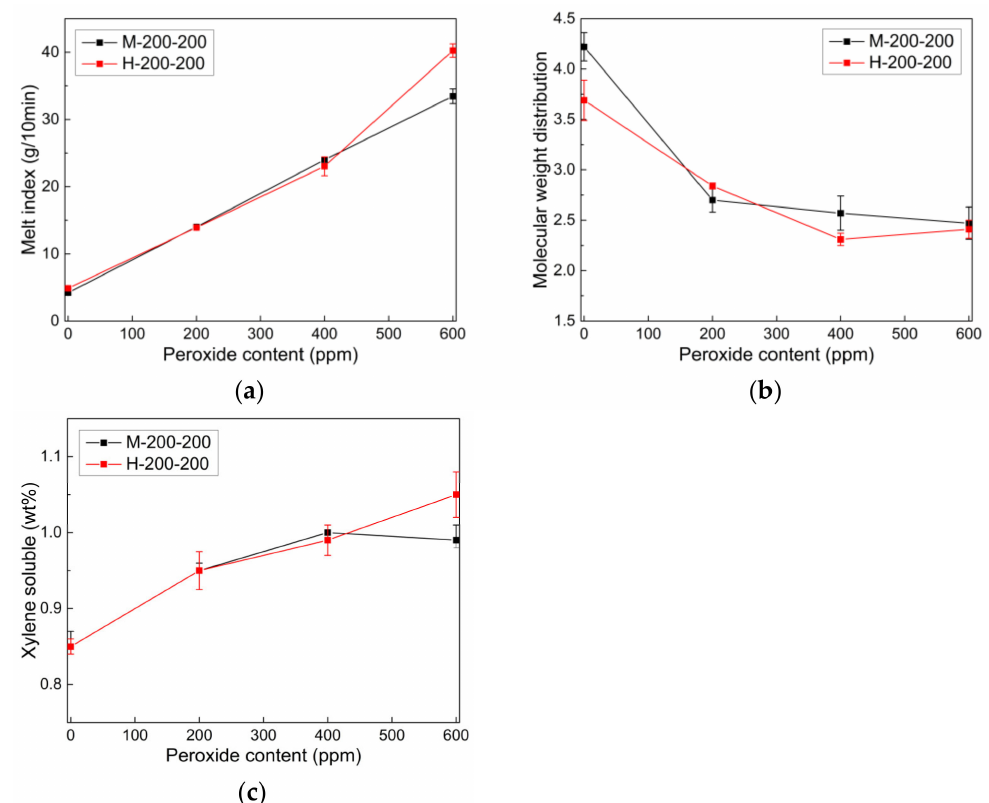
Figure 3. Effect of peroxide content on ( a ) melt index, ( b ) molecular weight distribution (MWD), and ( c ) xylene soluble (CXS) of CR-PPs produced using mild and harsh twin-screw extruders.